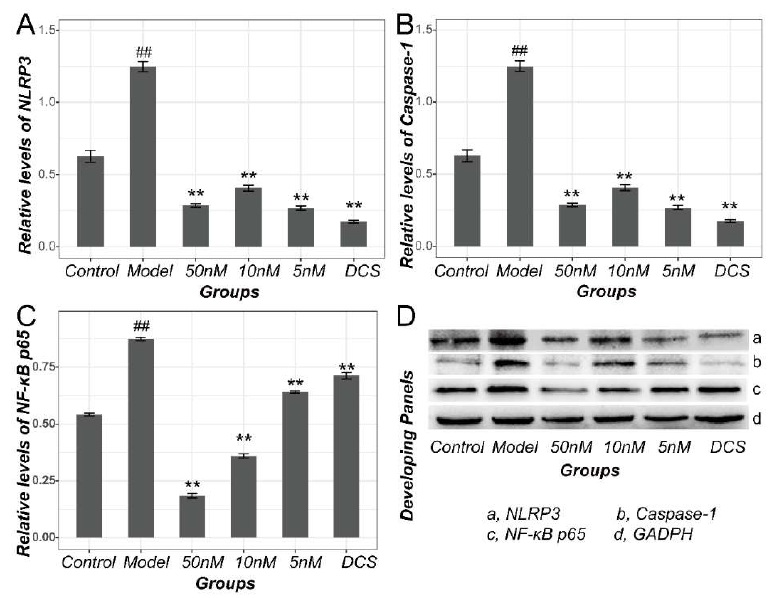
Figure 7. Protein levels of NF-κB and NLRP3/Caspase-1 pathway in RAW 264.7 cells. Results of optical density of NLRP3 ( A ), caspase-1 ( B ), NF-κB p65 ( C ) estimated by integrated optical density (IOD index) and normalized against β-actin. ( D )The representative Chemiluminescencez panels of all protein membranes. DCS, Diclofenac sodium. ## p < 0.01 vs. Control. ** p < 0.01 vs. Model.